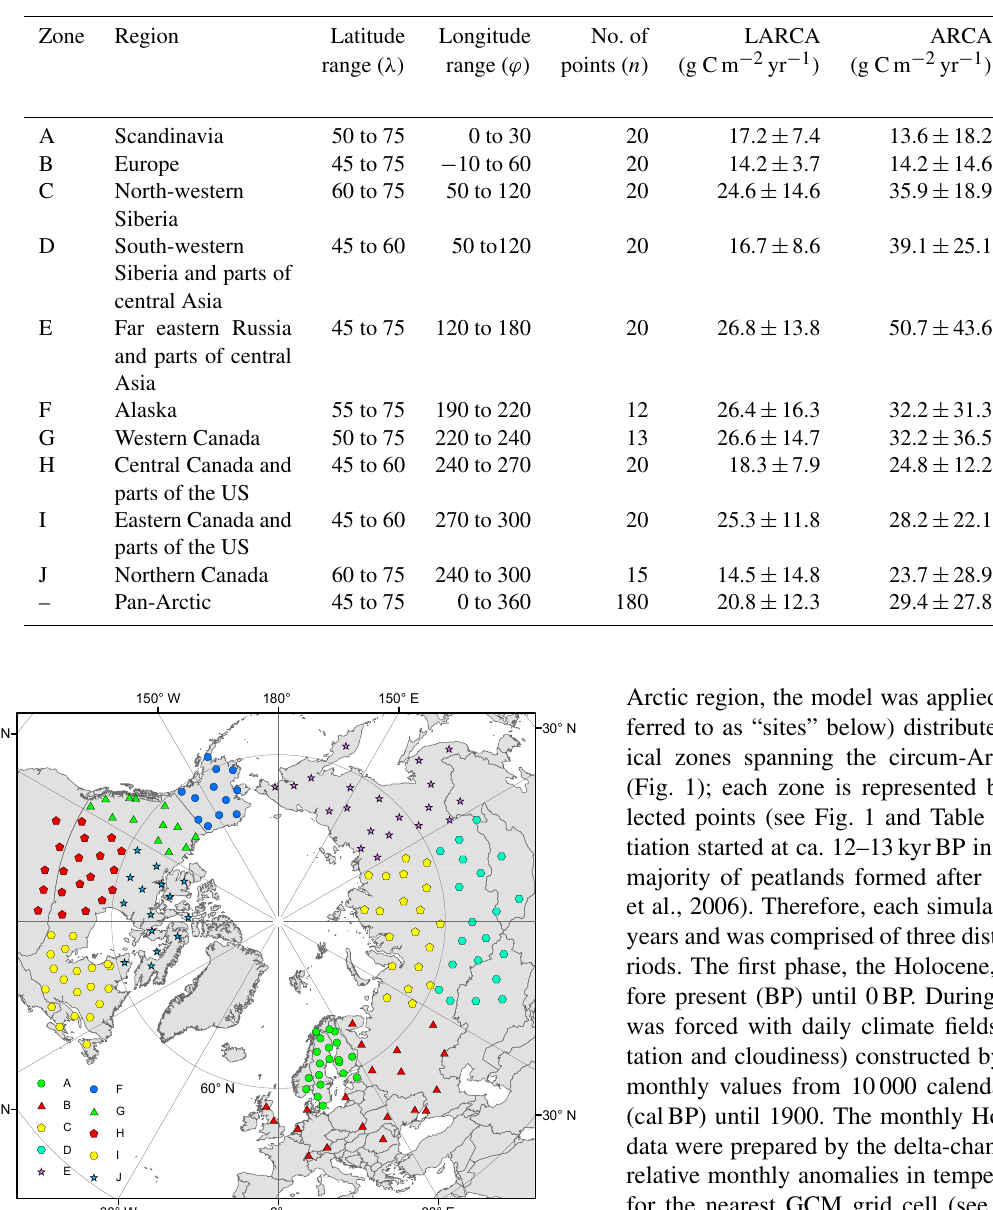
Figure 1. Location of 180 randomly selected simulation sites spread across 10 geographical zones between 45 and 75 ◦